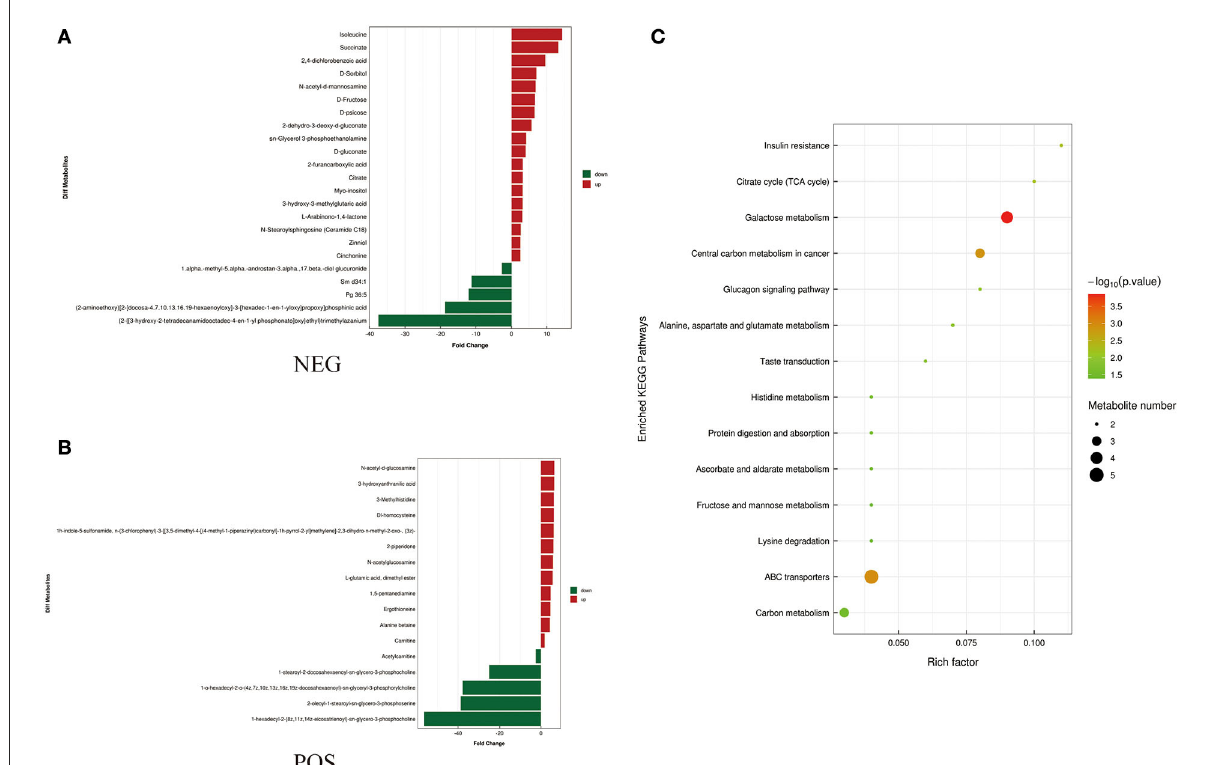
FIGURE4 Metabolites identified in seminal plasma by OPLS-DA model VIP > 1. (A, B) Was detected in negative and positive ions mode respectively. (C) KEGG analysis of the differential metabolites in seminal plasma of Duroc and Liang guang Small-spotted pig. The bubble size indicates the influencing factor in the topological analysis; the bubble color represents the P -value of enrichment